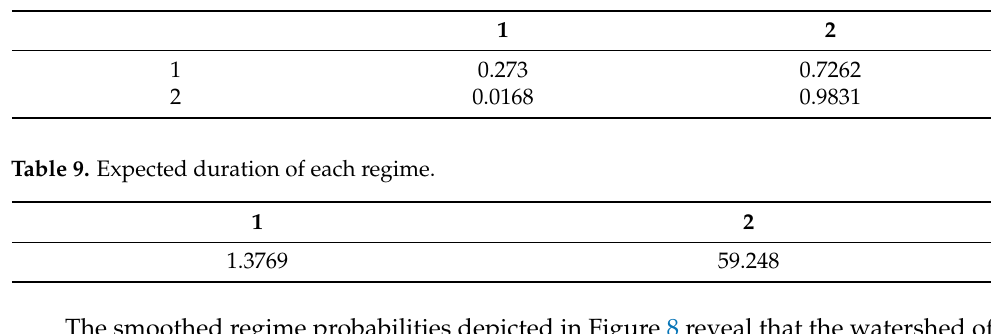
Table 8. Transition probability matrix.